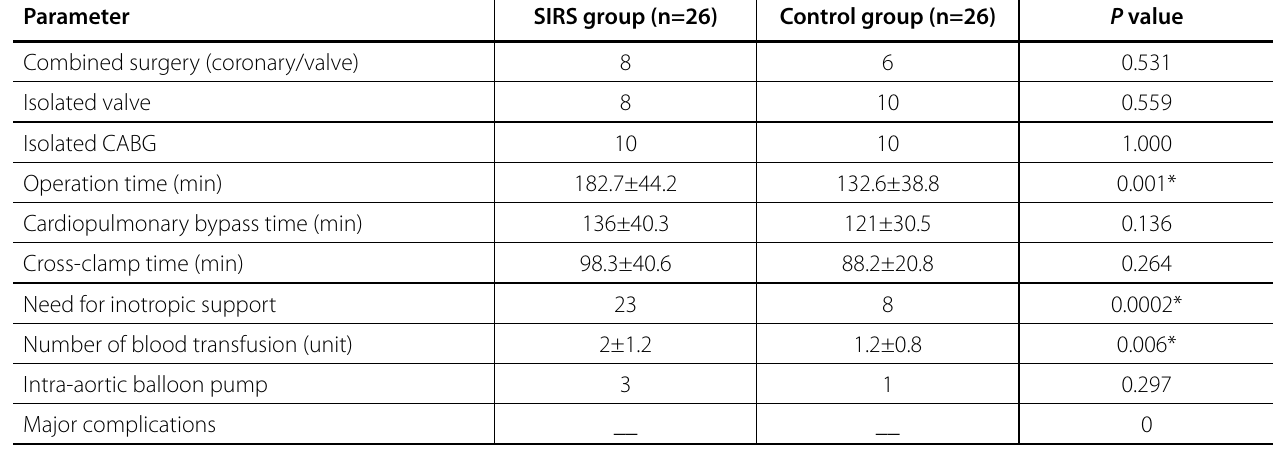
Table 2. Operative data of both groups.